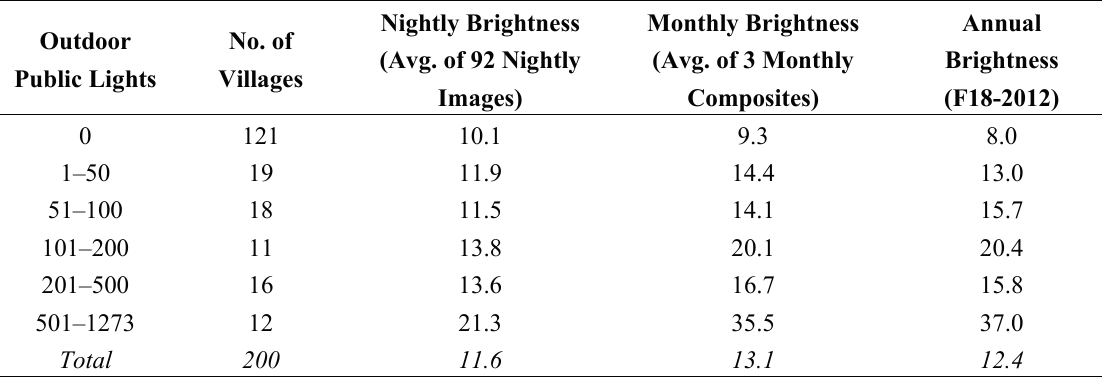
Table 2. Nighttime light output and public streetlights.